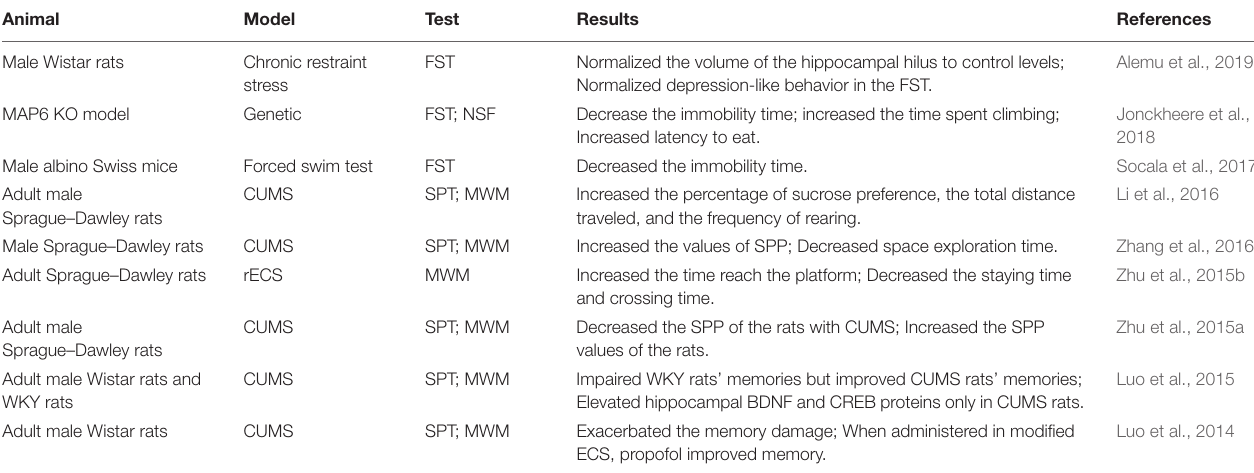
TABLE 2 | Effect of ECS on depression in the preclinical studies. Animal Model Test Results